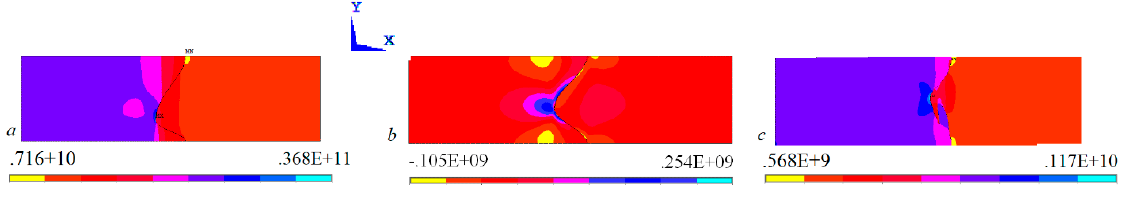
Figure 4. The local von Mises stresses corresponding to the tension along Oy -axis for ( a ) symmetric wave, ( b ) asymmetric wave, ( c ) wave with crest, Figure 3c.